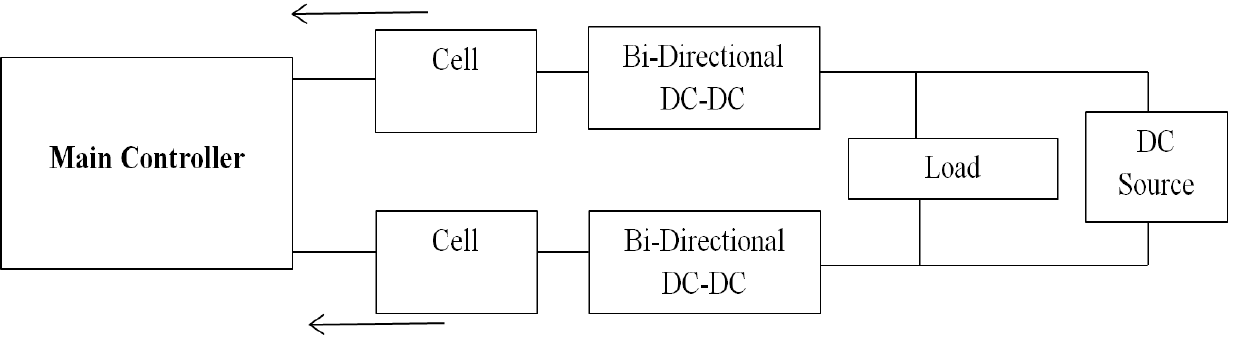
Figure 8. Balancing of SOH in two cell configuration .